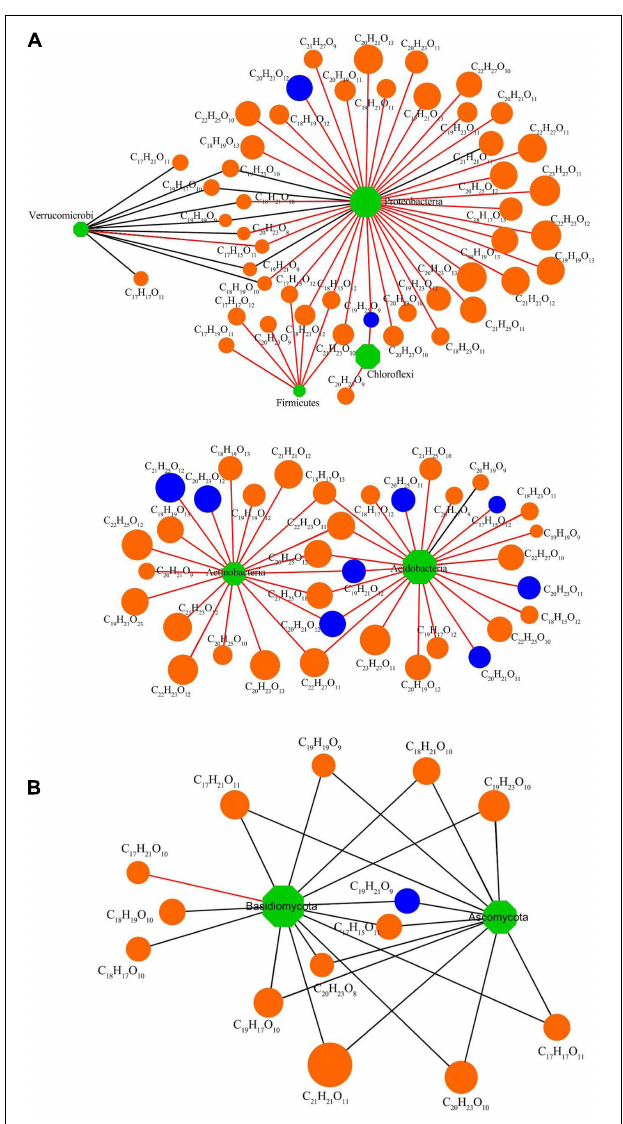
FIGURE 7 | (A) Interaction network analysis of the 100 most abundant bacterial operational taxonomic units (OTUs) and the 100 most abundant DOM molecules with significant correlation ( p < 0.01). (B) Interaction network analysis of the 50 most abundant fungal OTUs and the 100 most abundant DOM molecules with significant correlation ( p < 0.01). Circles are DOM molecules [orange, lignins/carboxylic-rich alicyclic molecules (CRAM) and blue, tannins]. Rhombuses are bacterial and fungal OTUs (green). DOM molecules’ relative abundances are proportional to node size. Positive correlations are indicated using red lines and negative correlations using black